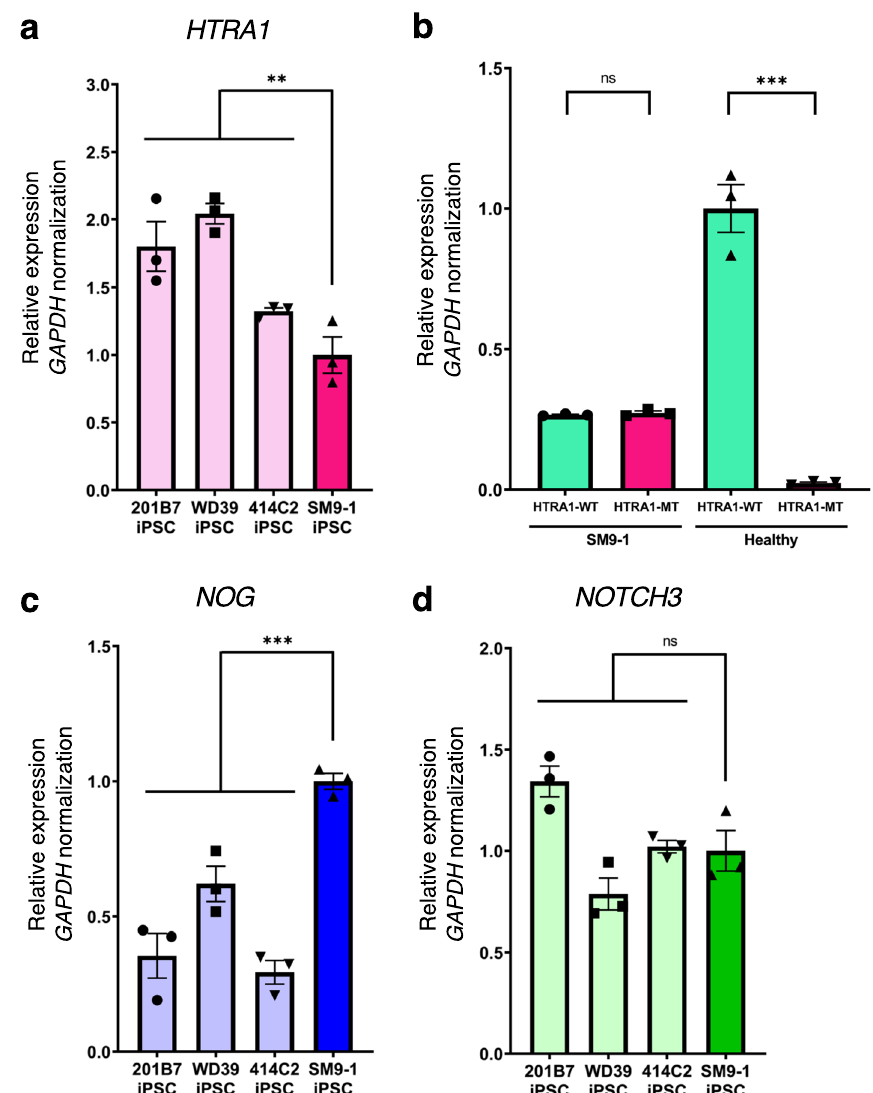
Fig. 4 Gene expression profiling of SM9-1 iPSCs. a RT-qPCR analysis to examine the expression levels of HTRA1 and associated genes in SM9-1 T lymphocytes and SM9-1 iPSCs compared with healthy iPSCs (201B7, WD39, and 414C2). Values represent the mean ** p < 0.01. b RT-qPCR analysis to compare the expression levels of wild-type and mutant HTRA1 RNA in SM9-1 iPSCs and healthy iPSCs (201B7). Values represent the mean SEM of technical triplicates; *** p < 0.001. c , d RT-qPCR analysis to examine the expression levels of NOG and NOTCH3 ± in SM9-1 T lymphocytes and SM9-1 iPSCs compared with healthy iPSCs (201B7, WD39, and 414C2). Values represent the mean triplicates; *** p <